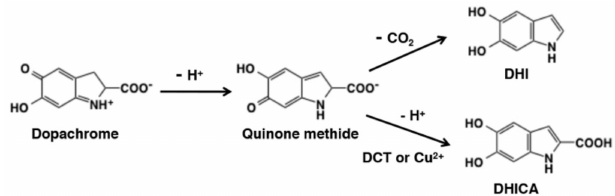
Figure 4. The proposed mechanism of DHI and DHICA from dopachrome via the quinone methide intermediate. In the formation of DHI, the acid group is spontaneously lost as carbon dioxide whereas with the help of either Cu 2+ or dopachrome tautomerase (DCT), the acid group can be kept intact to form DHICA. Figure adapted with permission from Ito et al. under Creative Commons Attribution—Published by MDPI AG